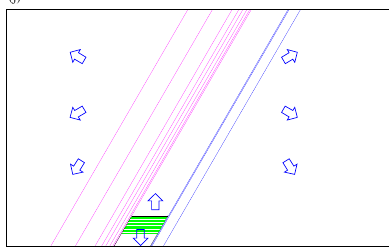
Figure 8. Simulated stress in the roof, bottom coal, and floor: ( a ) Horizontal stress in the roof; ( b ) shear stress in the roof; ( c ) vertical stress in the roof; ( d ) horizontal stress in bottom coal; ( e ) shear stress in bottom coal; ( f ) vertical stress in bottom coal; ( g ) horizontal stress in the floor; ( h ) shear stress in the floor; ( i ) vertical stress in the floor; and ( j ) measuring lines in the model.